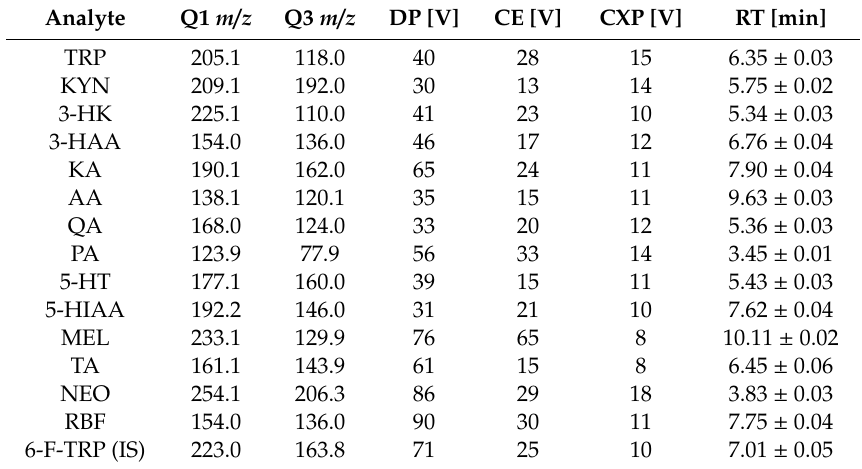
Table A1. QTRAP 4000 mass spectrometer settings for TRP metabolites, NEO, and RBF.